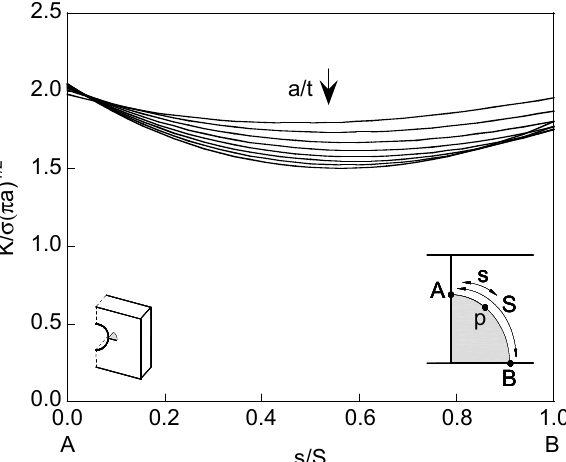
Figure 14. Dimensionless SIF along the crack front for the preferential fatigue propagation path (corrosion fatigue; cracks emanating from a hole with r = 2 t ).